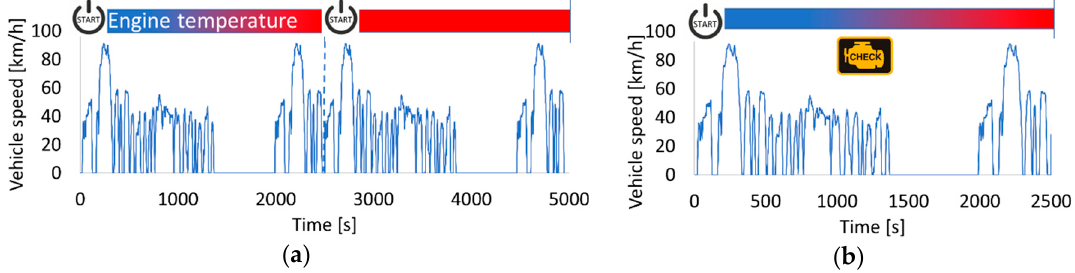
Figure 4. US OBD legislation ( a ) first and second preconditioning cycles; ( b ) emission tests cycle (example of Federal Test Procedures (FTP-75)).